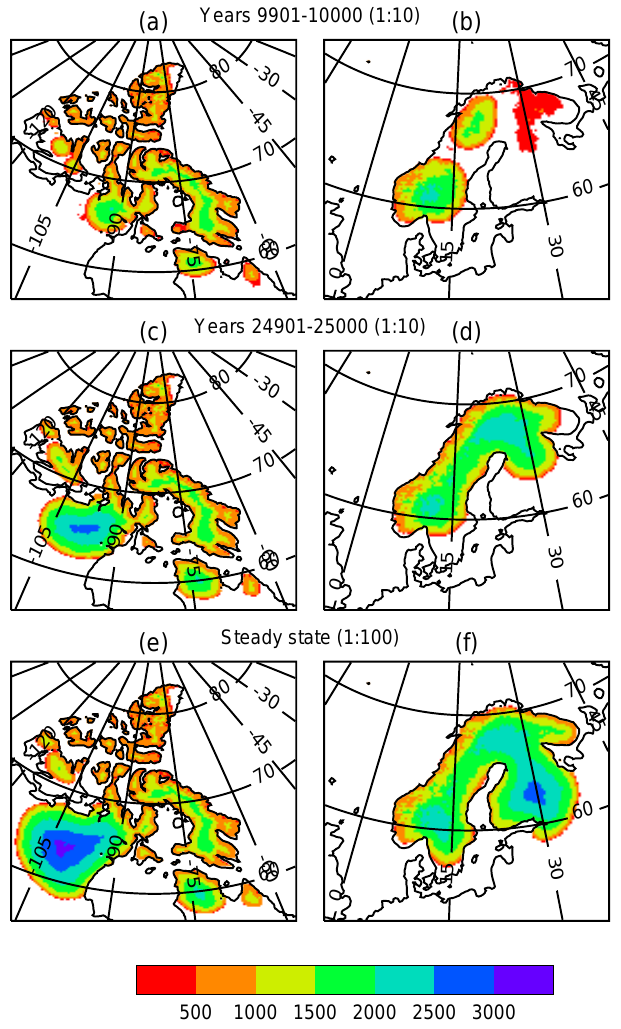
Fig. 8. Ice-sheet thickness (m) ( a , b ) after 10ka, ( c , d ) after 25ka and ( e , f ) in the steady state for the incipient glacial climate.